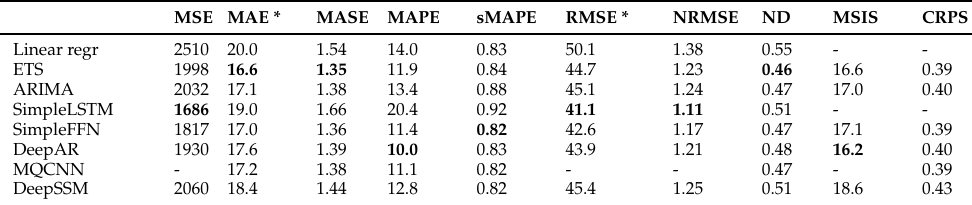
Table 1. Mean-aggregated error per forecast method. Reported numbers are measured over a forecast horizon H = 7 years. Probabilistic forecast indicators CRPS and MSIS could only be calculated for probabilistic forecasting algorithms. Further, SE based measures for MQCNN are not included because the network architecture does not allow deriving SE-based performance indicators in similar fashion as the other probabilistic forecast algorithms. Lower scores indicate better forecasts. MSE MAE * MASE MAPE sMAPE RMSE * NRMSE ND Linear regr 2510